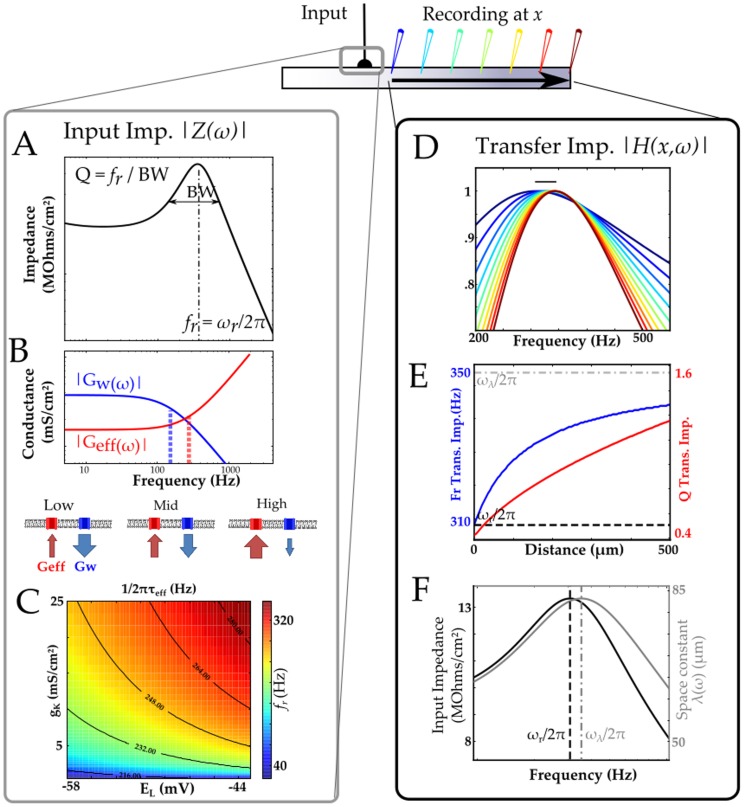
Resonance frequency in a cylindrical cable model.A. Input impedance and definition of resonance frequency () and resonance sharpness (Q-factor). B. Biophysical properties underlying resonance. A resonance is obtained if the effective admitttance  increases at higher frequencies (dotted red line) than the decrease of  (dotted blue line). C. Range of resonance frequencies, , of the input impedance ensuing from a realistic range of leak reversal potenial (EL) and potassium conductance density .  is color coded while isobars indicates the effective cut-off frequency (red dotted line in B). The resonance is set by the effective cut-off frequency  (black contour line) which depends on the potassium conductance density () and effective reversal potential of the membrane ();  is kept constant at 1 mS/cm2. D. Normalized transfer impedance of a semi-infinte cable measured at different position along the cable with positions color-coded (as in the schematics above). The range of resonance frequencies (310–340 Hz) expressed by the cable is displayed as an horizontal bar. E. The resonance of the membrane patch is different from the resonance frequency of the space constant. This inhrent mismatch produces the gradual change toward higher frequencies as distance between the recording and input sites increases F. The spatial profile of resonance frequency (blue solid line – left ordinate axis) best displays how  varies along the cable and is bounded by the resonance frequency of the input impedance (lower horizontal blue dotted line) and the resonance frequency of the space constant (upper horizontal blue dash-dotted line). The spatial profile of Q-factor is displayed as a red solid line (right ordinate axis). Both the membrane patch (A,B and C) and cable models (D and E) consist of a leak current, fast potassium current  and static H-type current  (see Methods).